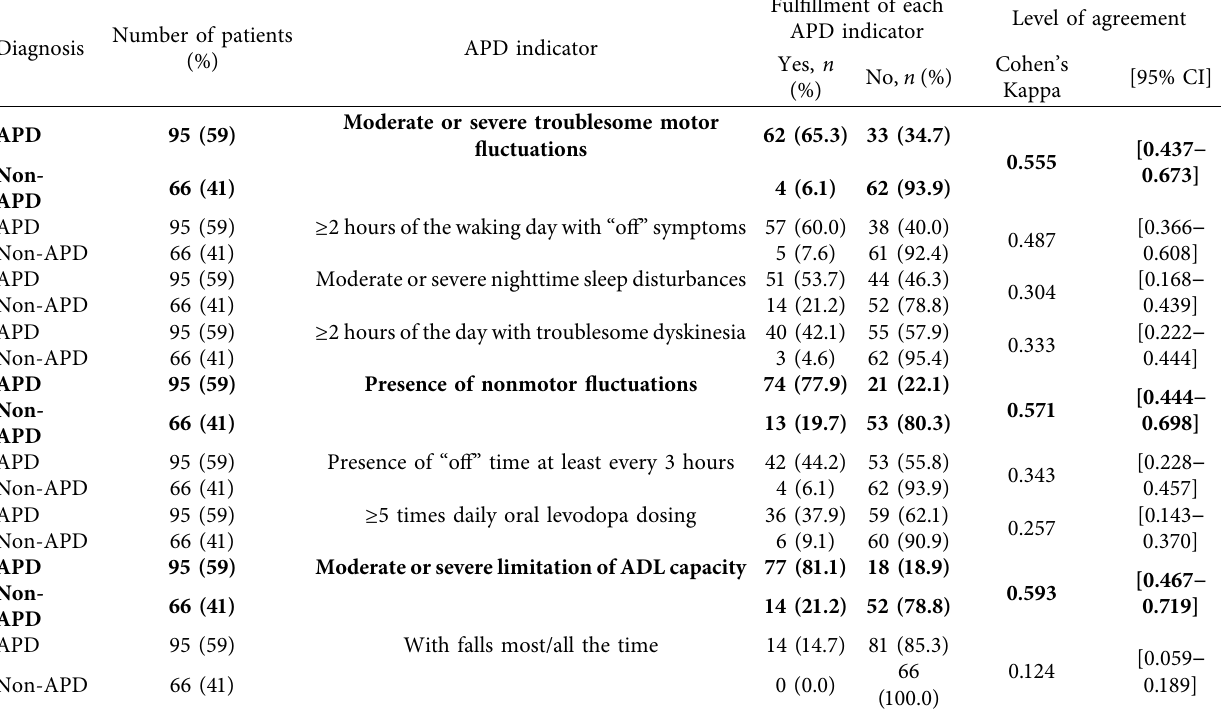
Table 6: Level of agreement between clinical judgement of APD diagnosis and fulfillment of each APD indicator. Diagnosis